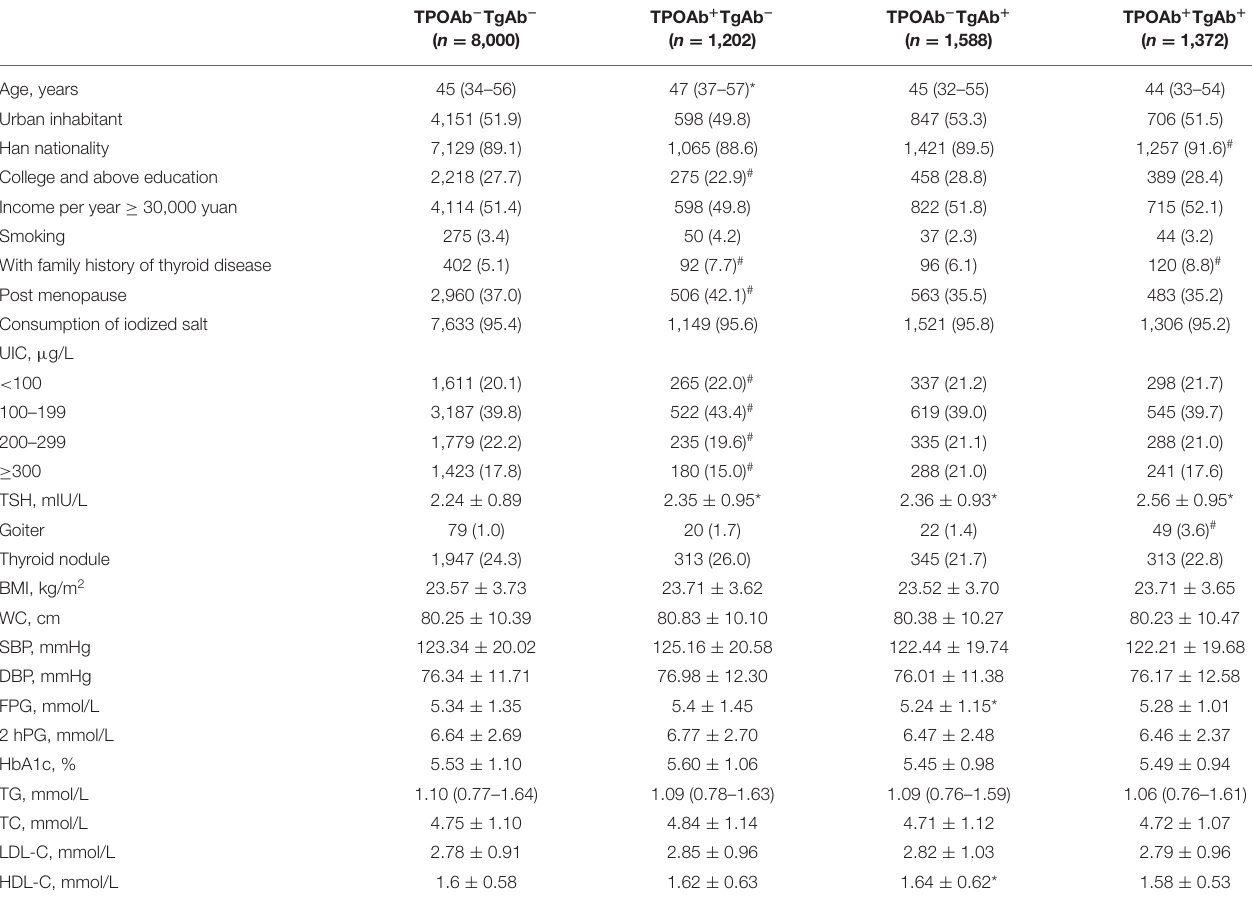
TABLE 2 | Characteristics of female subjects with differential expressions of serum TPOAb and